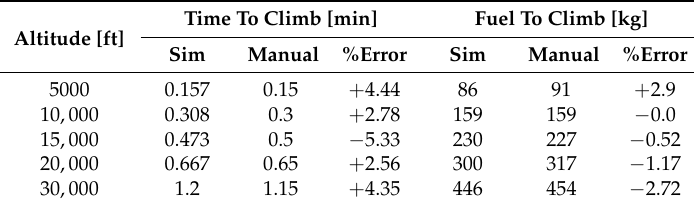
Table 2. Comparison of simulation results with data from the aircraft’s flight manual for a climb with maximum power setting for an aircraft AUM of 18,000